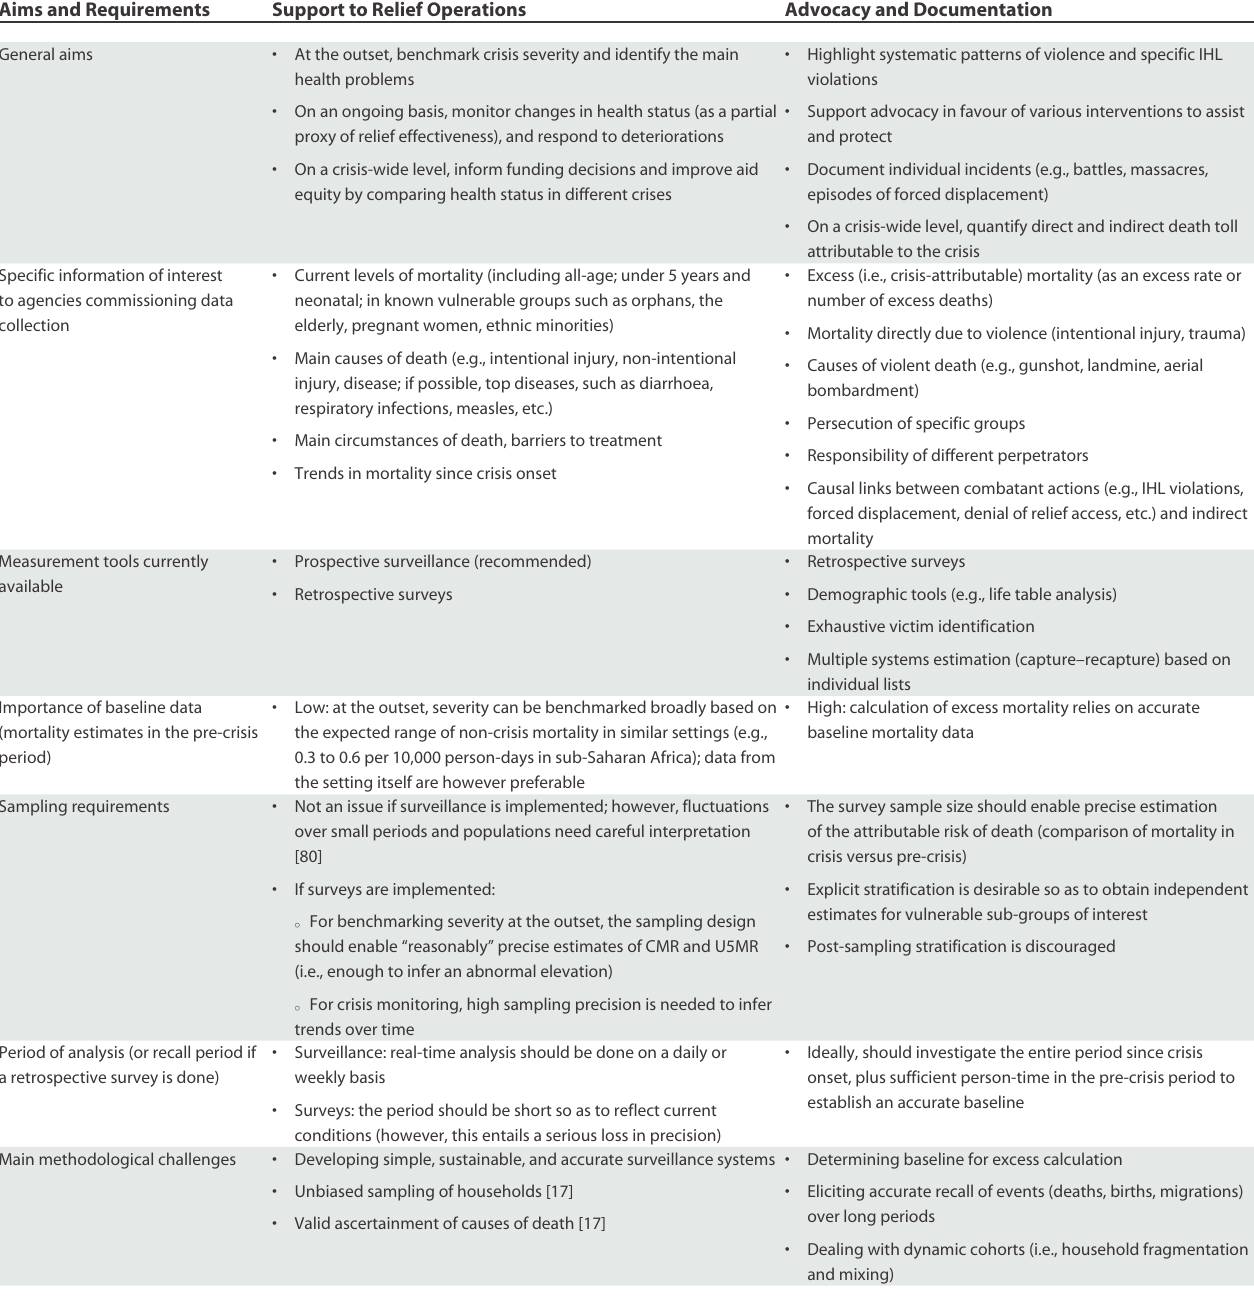
Table 1. Aims and Requirements of Mortality Data Collection According to Its